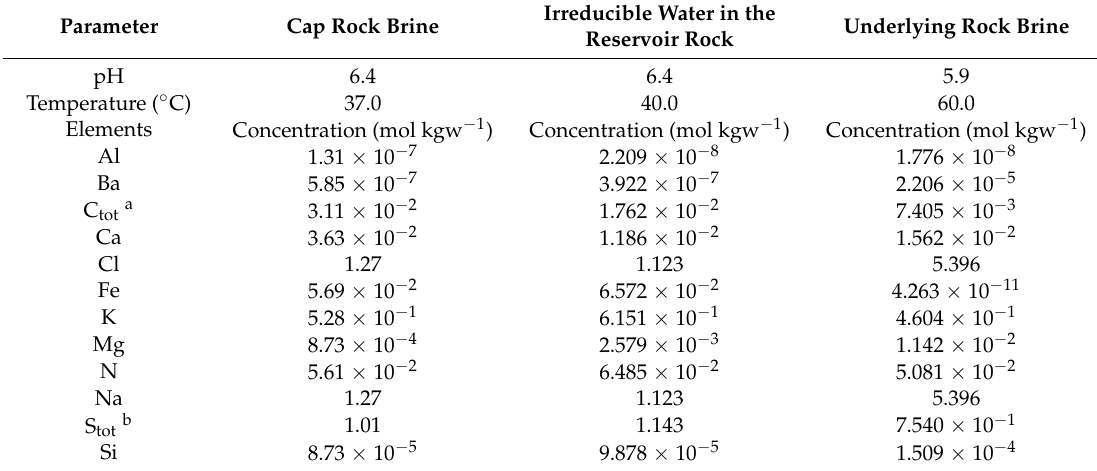
Table 3. Composition of the initial irreducible water in the reservoir rock, the cap rock brine, and the underlying rock